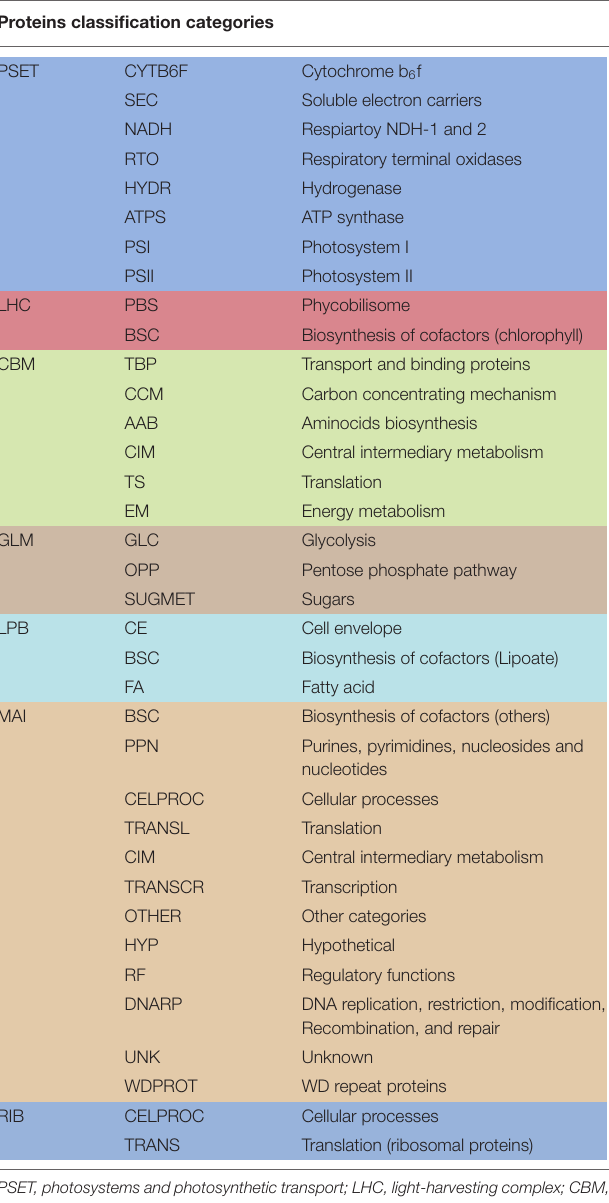
TABLE 1 | Proteome classification categories used for mass fraction